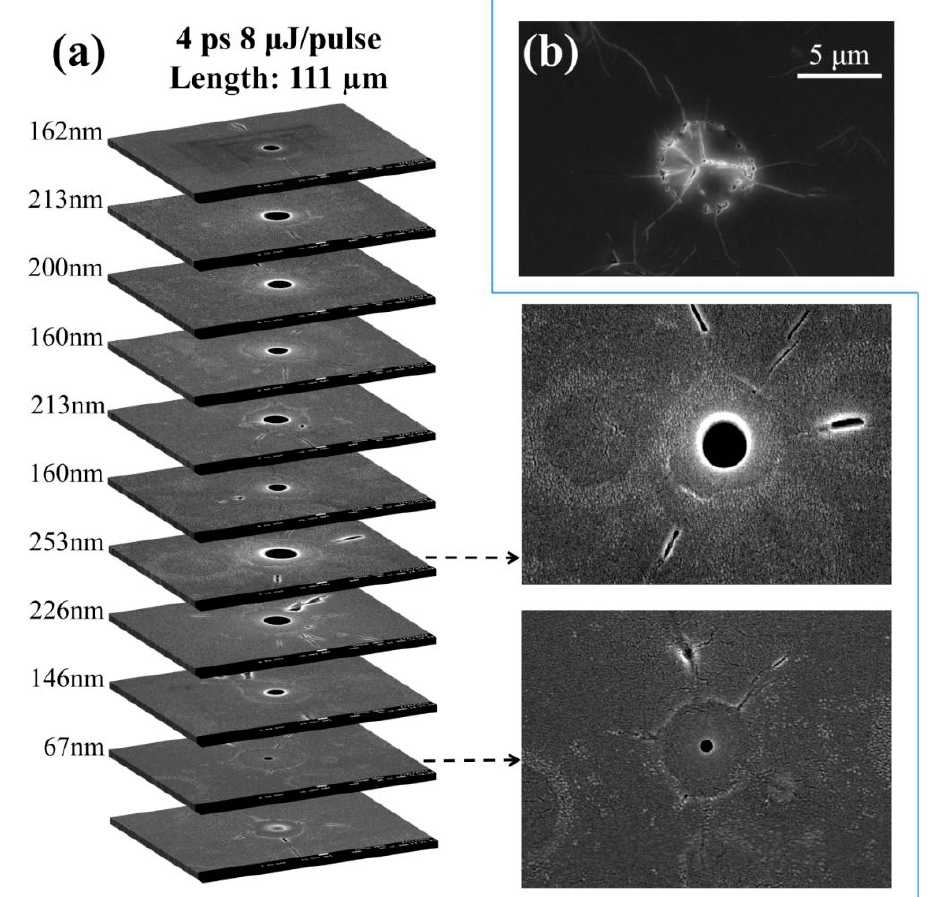
Figure 2. ( a ) Tomography of hole drilling by a single ultrafast Bessel beam pulse. Pulse energy is 8 µ J with 4 ps pulse duration. ( b ) Radial configuration of structure induced by 150 fs Gaussian beam pulses.